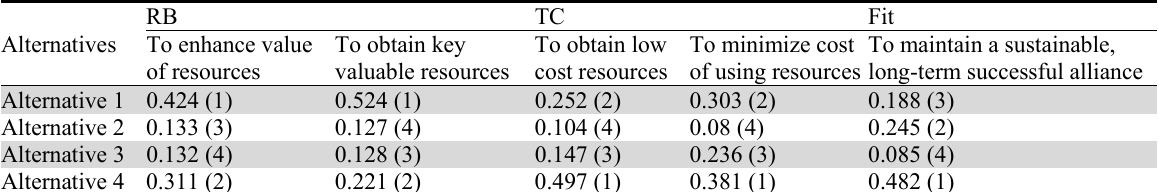
Weights of alternatives based on AHP